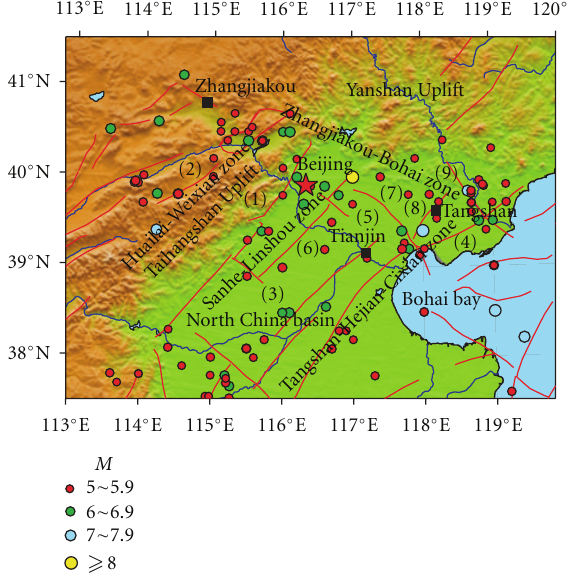
Figure 1: Geological setting and historical earthquakes in the BTT region. Colorful circles show the earthquakes with magnitudes ( M ) equal to or greater than 5.0 that occurred in the BTT region since 780 BC. Black squares denote major cities. Red star shows the capital of China. Thick curved lines show major active faults: (1) Tongxian-Nanyuan Fault; (2) Weixian-Yanqing Fault; (3) Laishui Fault; (4) Changli-Ninghe Fault; (5) Nankou-Sanhe Fault; (6) Xiadian-Fengheying-Caojiawu Fault; (7) Ninghe Fault; (8) Tangshan-Dacheng Fault; (9) Western Luanxian Fault.